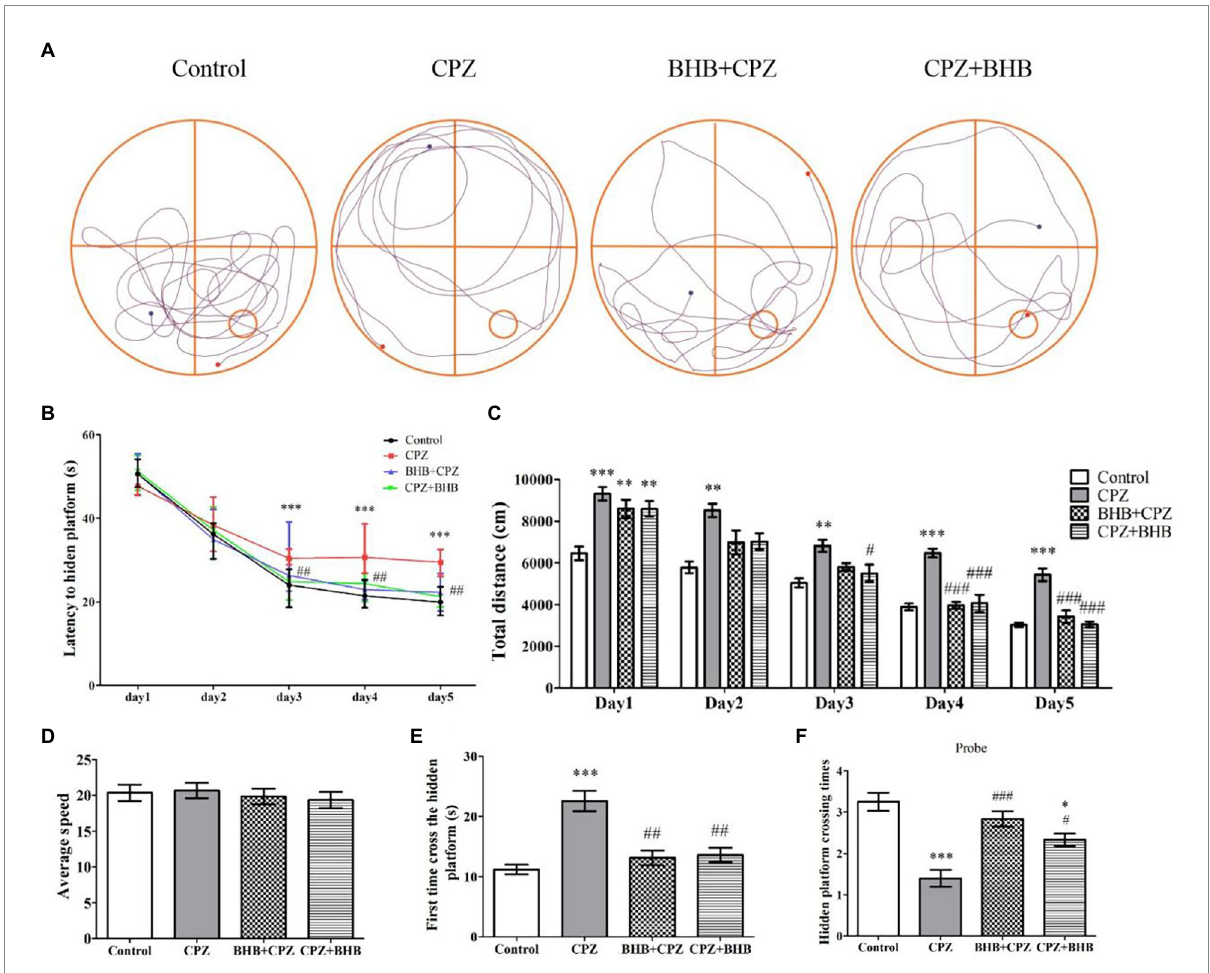
FIGURE 4 Effect of BHB on memory impairment in CPZ-fed mice. (A) Representative mouse search paths on the 6 th day after starting with the MWM experiment, blue dots represent the starting point and red dots represent the final point. The red square indicates the platform location and the blue square indicates the start location. (B) Escape latency of the control, CPZ, BHB + CPZ and CPZ + BHB groups over five-day training. (C) Total distance traveled during training days and (D) average speed among the four groups were recorded (mm/s). (E) First time to cross the hidden platform and (F) the hidden platform crossing times among the four groups. Data are presented as mean ± SEM. N = 10 mice/group. * p < 0.05, ** p < 0.01, and *** p < 0.001 versus the control group; # p < 0.05, ## p < 0.01, and ### p < 0.001 versus the CPZ